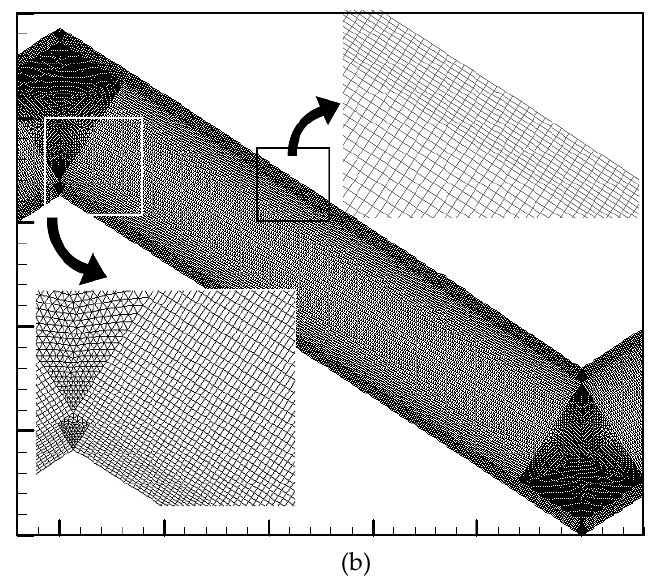
Figure 3. ( a ) Effect of grid resolution on liquid-fraction and ( b ) the selected grid.